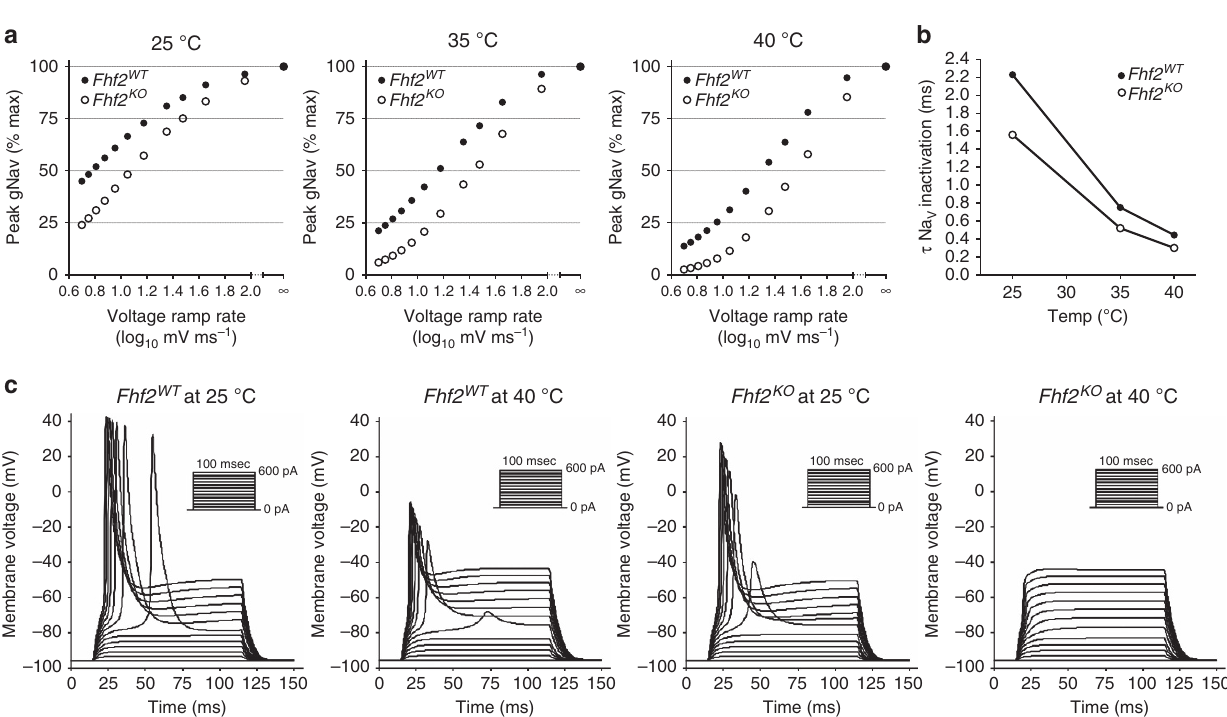
(Invitrogen) and transferred to nitrocellulose (Bio-Rad) overnight at 4 (cid:2) C. Nitrocellulose membranes were incubated in blocking buffer consisting of PBS (Na V 1.5) or TBS (FHF2) with Tween-20 (0.05%) and 5% nonfat dry milk. Membranes were then incubated with specific primary antibodies diluted in 5% nonfat dry milk in PBST/TBST (0.05%) overnight at 4 (cid:2) C followed by wash steps and secondary antibodies (Li-Cor). Antigen complexes were visualized and quantified with the Odyssey Imaging System (Li-Cor). The uncropped western blot images shown in Fig. 1c are displayed in Supplementary Fig. 5. Cardiomyocyte enzymatic dissociation experiments . Cardiac cells were dissociated from adult hearts that were Langendorff perfused and enzymatically digested according to AfCS Procedure Protocols PP00000125. Mice were heparinized (500Ukg (cid:2) 1 ) and killed with 100% carbon dioxide. Hearts were surgically removed via thoracotomy and immersed in ice cold perfusion buffer (composition (mmoll (cid:2) 1 ): 113 sodium chloride (NaCl), 4.7 potassium chloride (KCl), 0.6 potassium phosphate monobasic (KH 2 PO 4 ), 0.6 sodium phosphate dibasic (Na 2 HPO 4 ), 1.2 magnesium sulphate heptahydrate (MgSO 4 .7H 2 O), 12 sodium bicarbonate (NaHCO 3 ), 10 potassium bicarbonate (KHCO3), 10 HEPES buffer solution, 30mM taurine, 5.5mM glucose and 10 2,3-Butanedione monoxime (BDM)). The aorta was cannulated and Langendorff perfused with perfusion buffer at a constant flow rate of 3mlmin (cid:2) 1 for 3min. The perfusate was then switched to